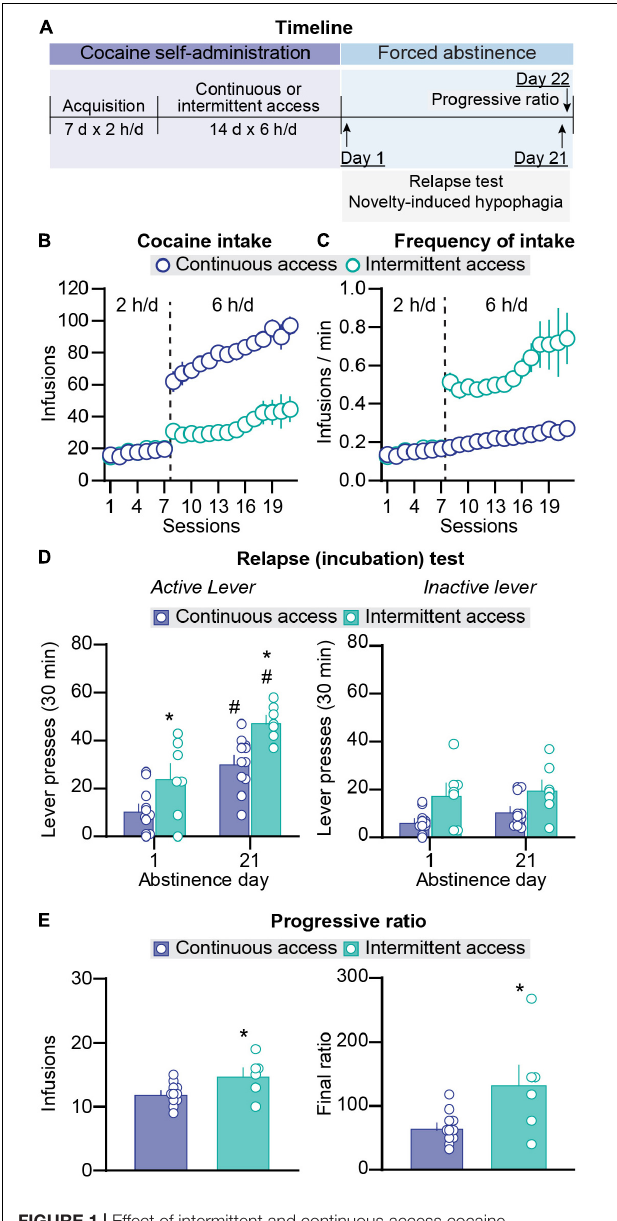
FIGURE 1 | Effect of intermittent and continuous access cocaine self-administration on incubation of craving and progressive ratio reinforcement schedule responding. (A) Timeline of the experiment. (B) Total cocaine intake. Mean ± SEM number of infusions per session (continuous access n = 11, intermittent access n = 7). (C) Frequency of intake. Mean ± SEM number of infusions per min of cocaine access per session. Left side in all graphs (sessions 1–7): 2-h continuous access self-administration acquisition sessions; right side in all graphs (sessions 8–21): 6-h continuous or intermittent self-administration sessions (continuous access n = 11, intermittent access n = 7). (D) Relapse (incubation) test. Mean ± SEM number of active (left) and inactive (right) lever presses per session (continuous access n = 11, intermittent access n = 7 for both day 2 and day 21). (E) Progressive ratio reinforcement schedule. Mean ± SEM cocaine infusions (left) and final ratio completed (right) and during a single session in which lever presses were reinforced under a progressive ratio reinforcement schedule on abstinence day 22 (continuous access n = 11 intermittent access n = 6). #Different from day 1 within each schedule, p < 0.05. *Different from continuous access, p < 0.05.